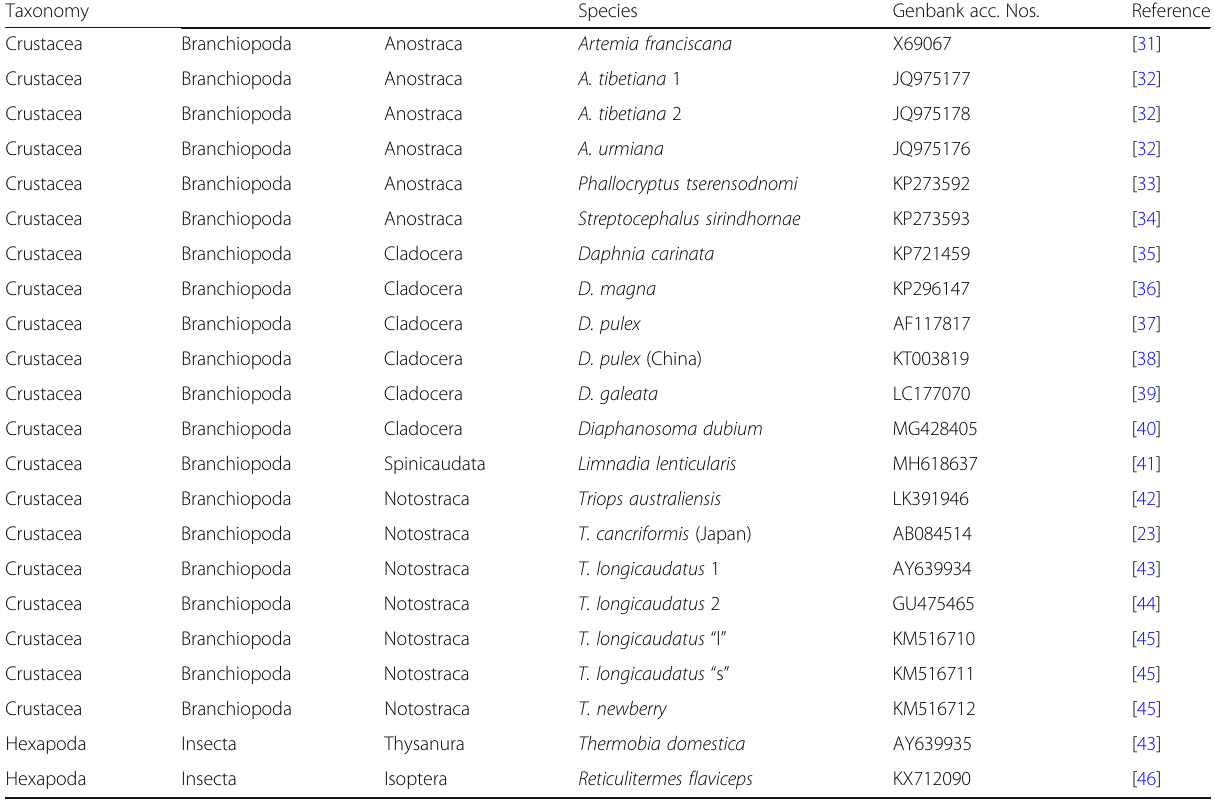
Table 1 Samples obtained from Genbank for comparative and phylogenetic analyses Taxonomy Genbank acc.